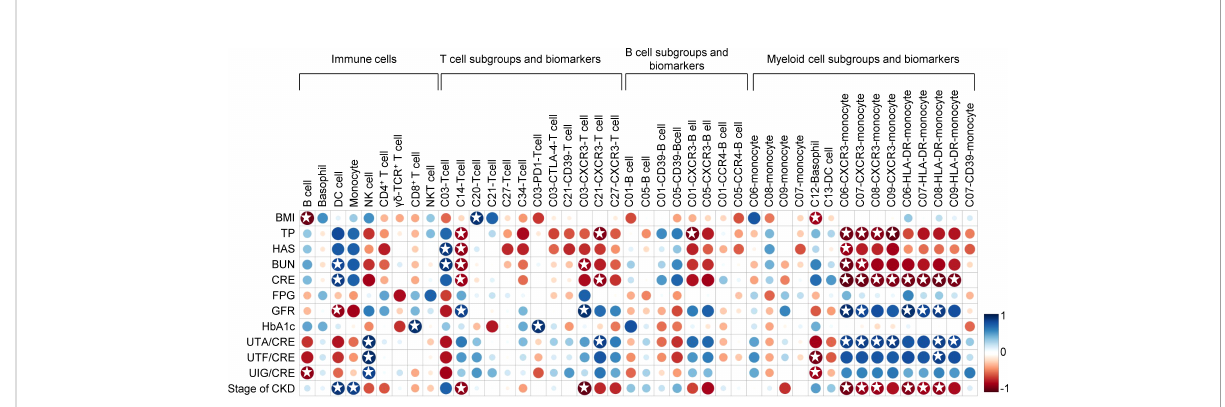
FIGURE 5 Correlation analysis between identi fi ed immune populations and renal clinical parameters as well as diabetic markers in the T2D-DN patients. Rows correspond to renal clinical parameters and diabetic markers, and columns correspond to the speci fi c immune cell subsets and biomarkers. Blue and red colors denote positive and negative associations, respectively. The intensity of the colors represents the degree of association between the immune populations and clinical parameters assessed by Pearson correlation analysis. Stars means P <